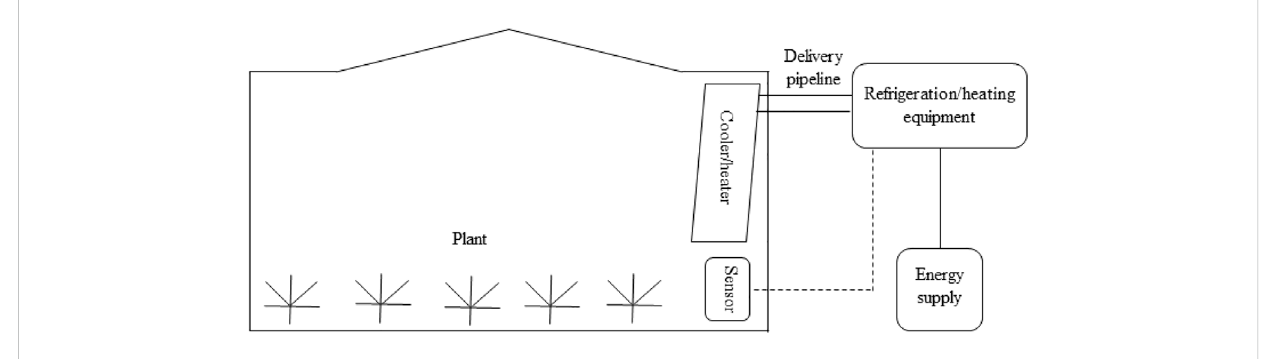
FIGURE 1 Greenhouse energy supply system.